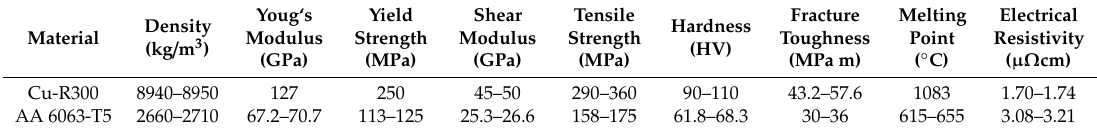
Table 2. Physical and mechanical properties of the Al flyer and of the Cu target used in this